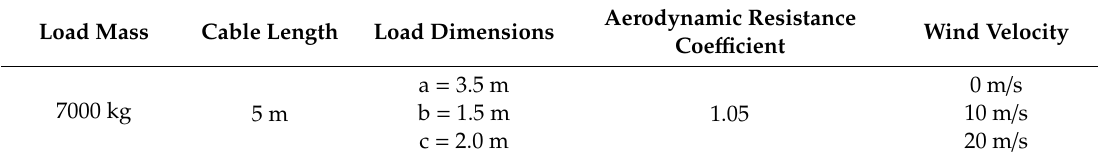
Table 1. Parameters of the calculation model.